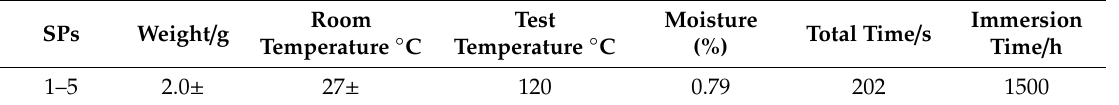
Table 2. Overall evaluation of moisture